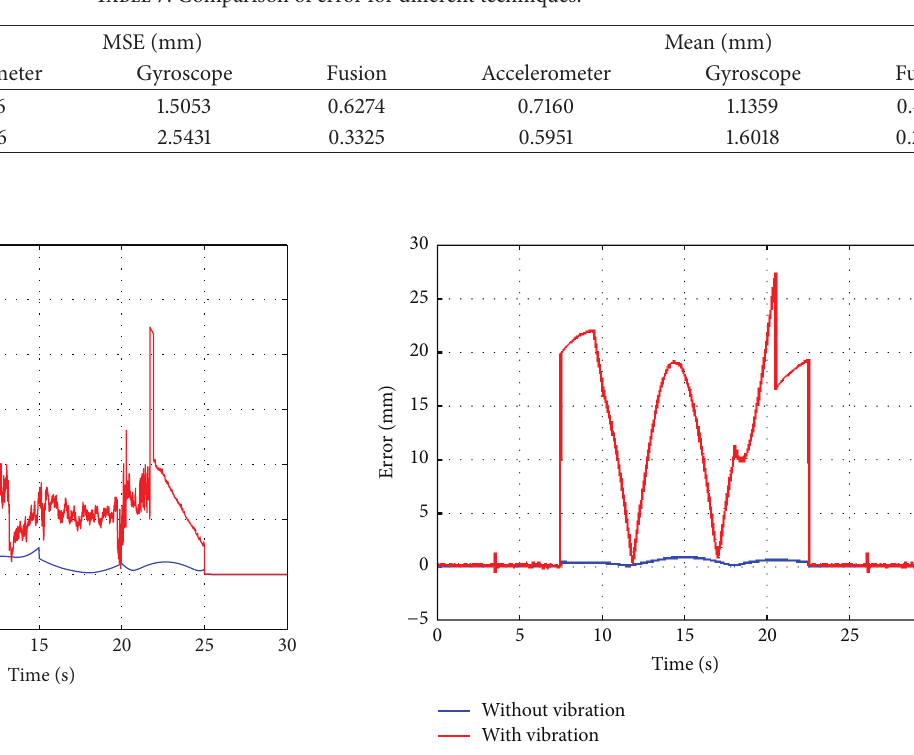
Table 7: Comparison of error for different techniques.